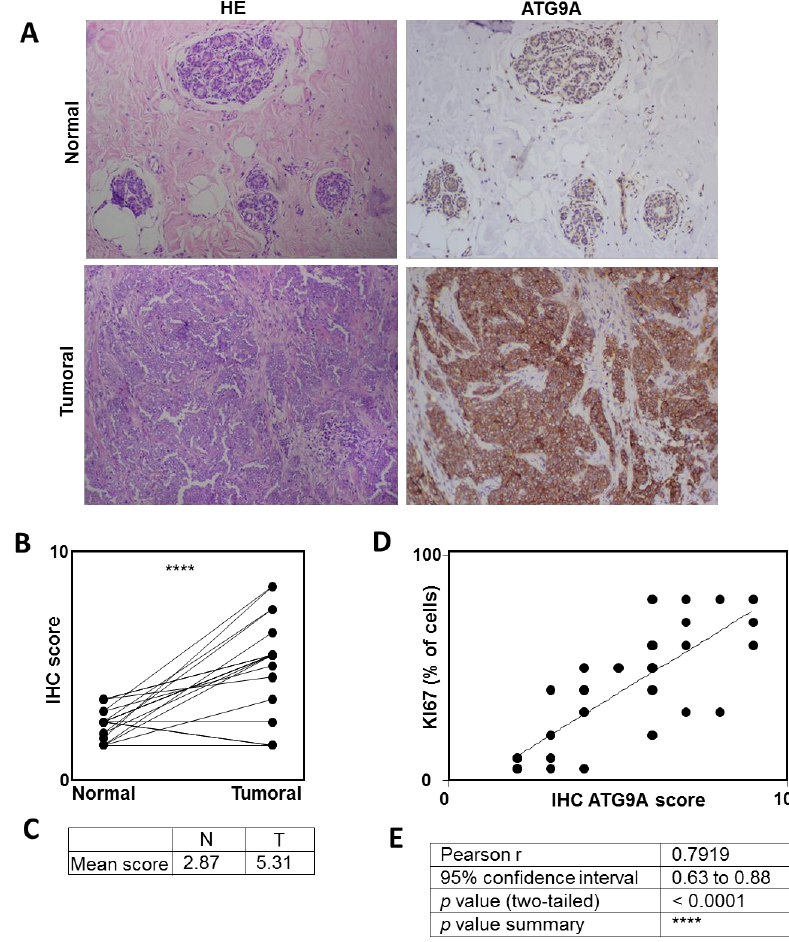
Figure 2. ATG9A protein overexpression in triple negative breast cancer. Quantification of ATG9A protein levels using IHC in triple negative breast cancer (TNBC) biopsies compared to matched healthy adjacent tissues. ( A ) Representative images of ATG9A protein staining in tumor and healthy tissues (left: HE (hematoxylin & eosin) staining, right: ATG9A staining). ( B, C ) Quantification of ATG9A staining in 21 patients. ( D ) Correlation between ATG9A score with KI67 staining in tumors. ( E ) Quantification.